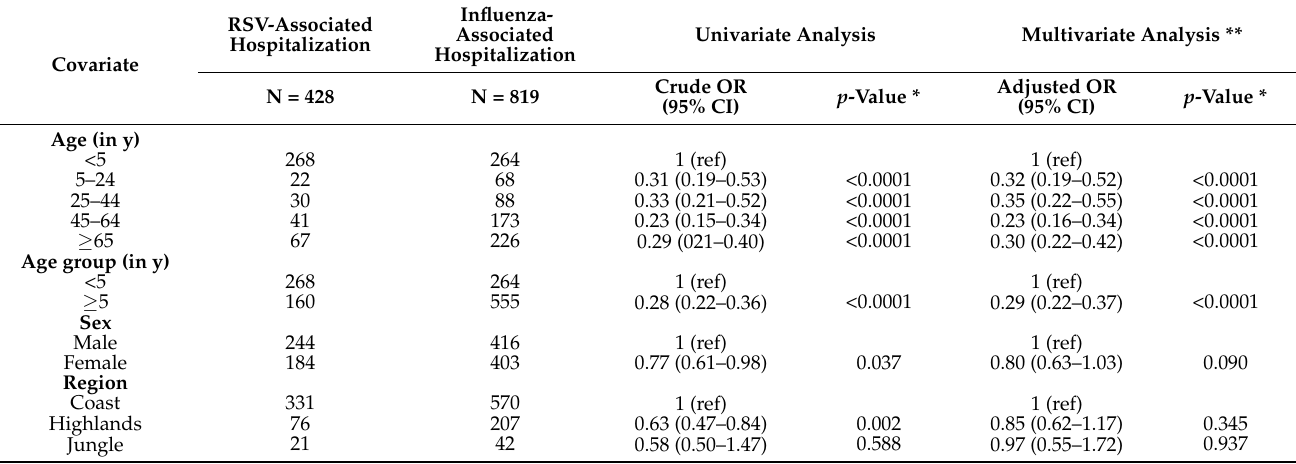
Table 6. Pneumonia associated with the RSV compared to the influenza virus among patients hospitalized in Peru,